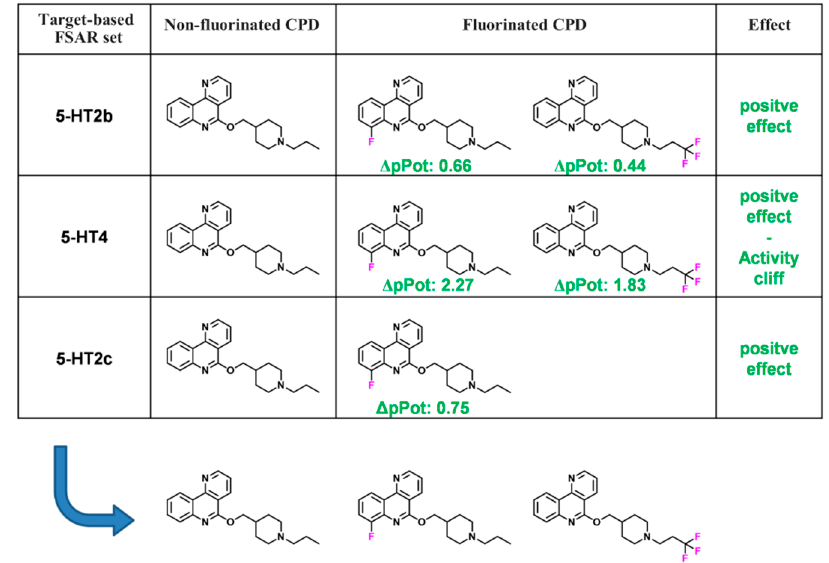
Figure 3. FSAR sets with multiple targets. Three target-based FSAR sets with Δ pPot values and their individual potency effects for the serotonin 2b (5-HT2b) receptor, serotonin 4 (5-HT4) receptor, and serotonin 2c (5-HT2c) receptor are shown (from top to bottom). For network analysis, target-based FSAR sets having the same non-F compound were combined into a “FSAR meta set” with a consensus potency effect.